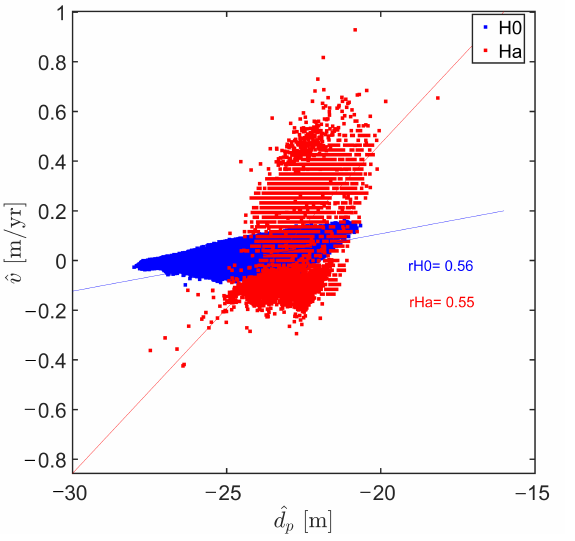
Figure 14. Relationship between predicted variables using accepted H 0 and H a models, where rH 0 and rH a gives the respective correlation